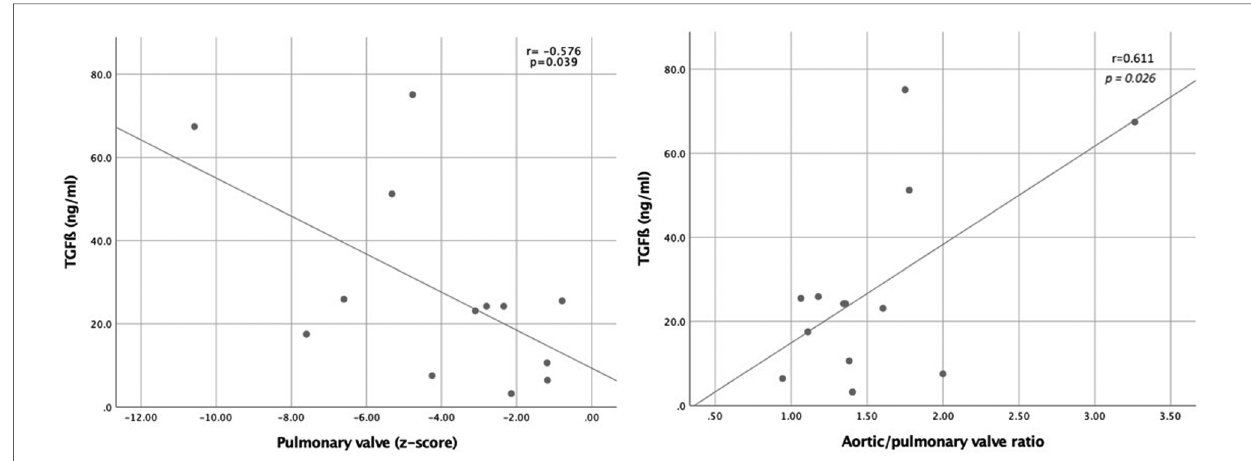
FIGURE 3 Relationship between umbilical cord concentration of transforming growth factor ß (TGFß) and pulmonary valve diameter z -scoress (left graphic) and aorta/pulmonary ratio (right